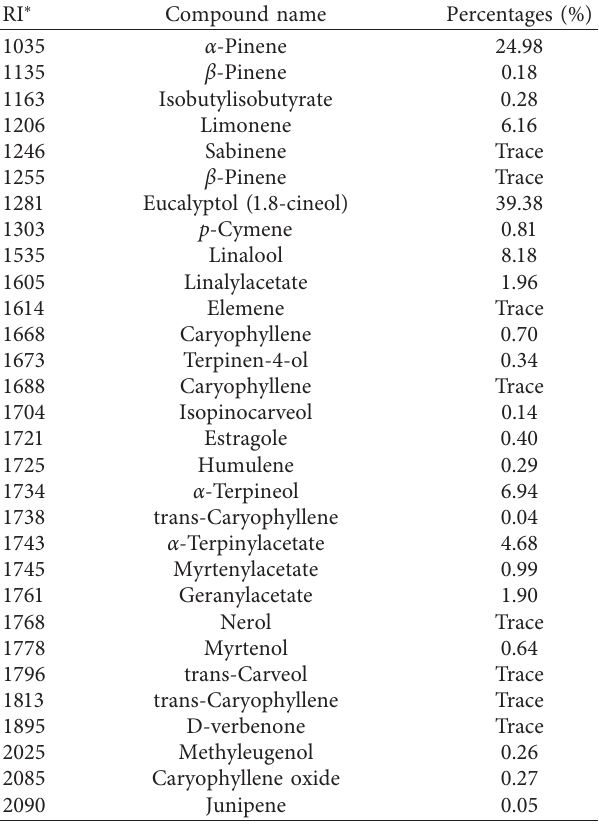
Table 2: Chemical compositions of the volatile essential oils (%) of myrtle